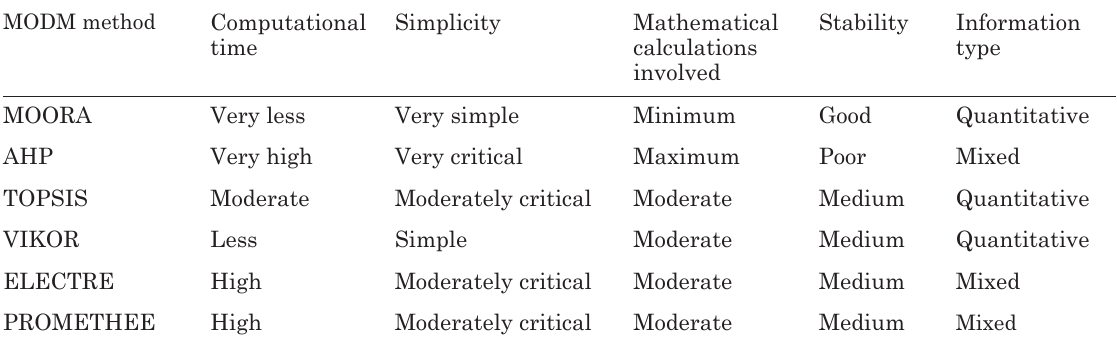
Table 1. Comparative performance of some popular MODM methods (Chakraborty, 2011) MODM